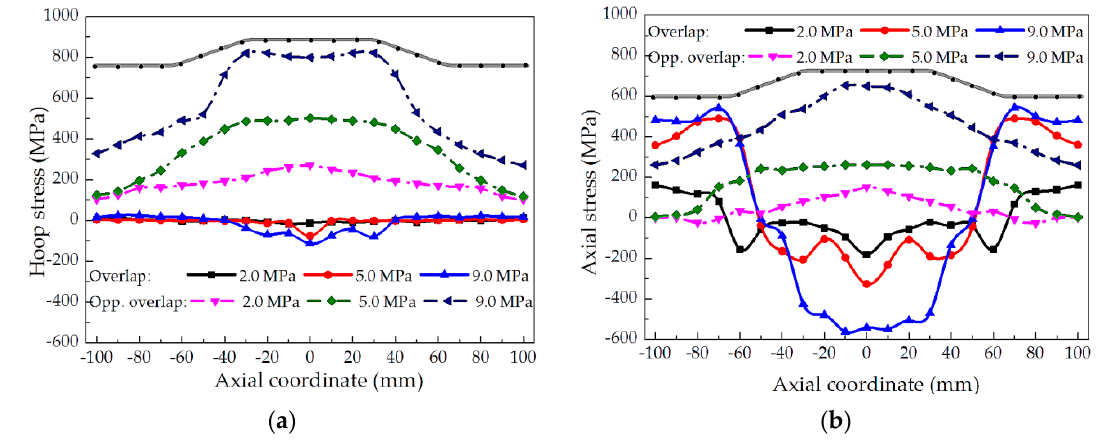
Figure 16. Stress distribution along axial direction. ( a ) Hoop stress; ( b ) axial stress.